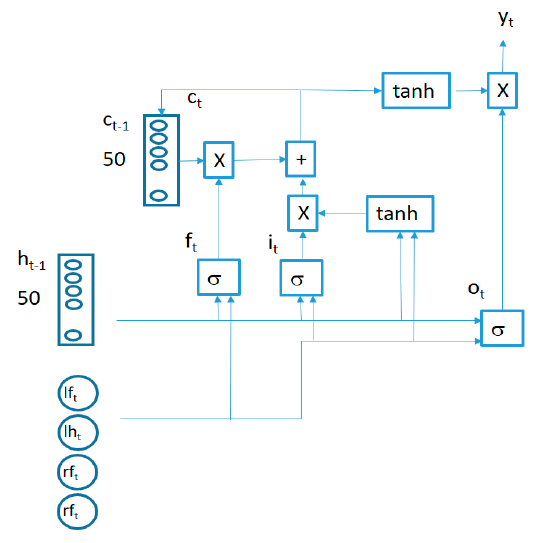
Figure 5. LSTM cell structure.